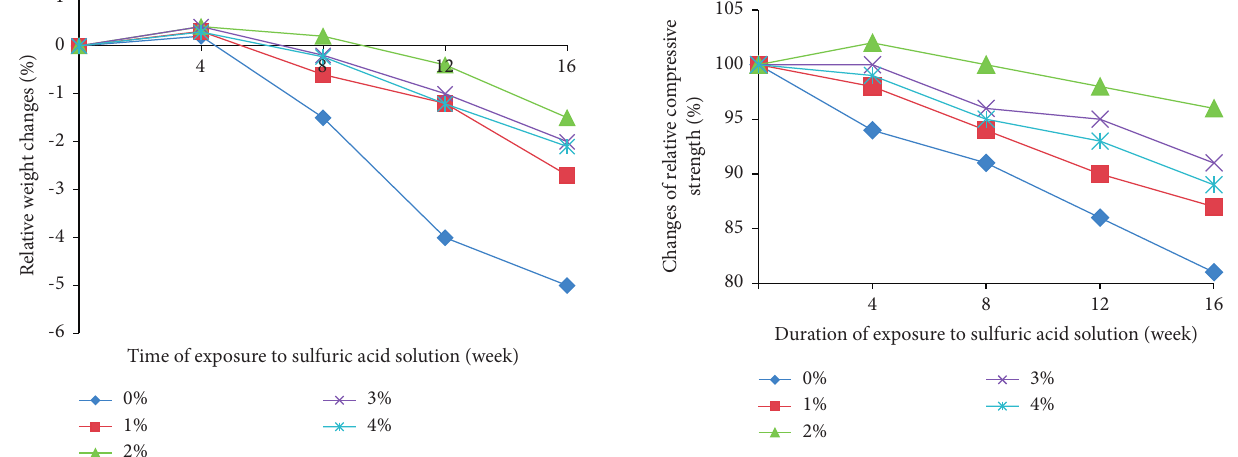
Figure 13: Changes in relative compressive strength of the con- crete samples containing Al 2 O 3 nanoparticles in sulfuric